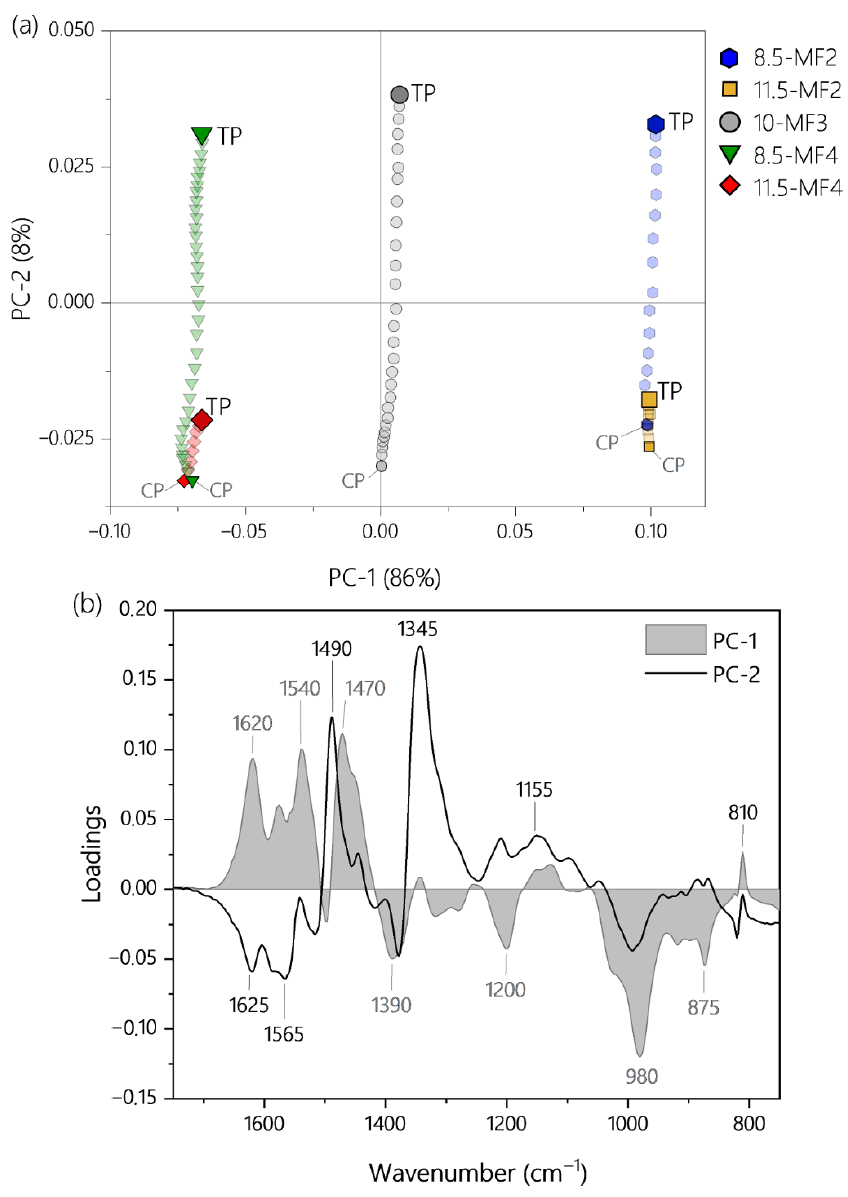
Figure 8. Process trajectories for PCA. ( a ) Score plot (PC1 vs. PC2) of the PCA analysis of the final condensation phase of resin synthesis in homogenous phase for five of the prepared MF resins. The score plot shows the process trajectories of the factorial experiments (triangular, rhombic, hexagon and square symbols) and center point (circle) settings of the MF resin syntheses. ( b ) Loadings plots of PC1 and PC2 of the PCA analysis of the reaction in homogenous phase procedure. For better distinction of the two PCs, PC1 has a light grey background and PC2 is a solid line.